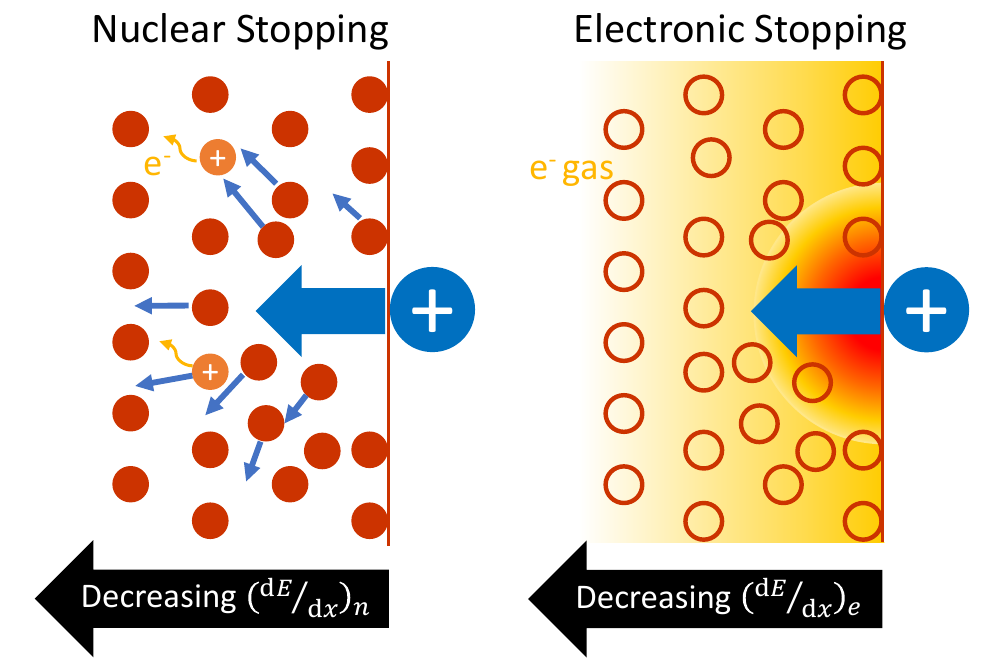
Figure 2. Nuclear and electronic stopping power as a projectile ion penetrates a metallic